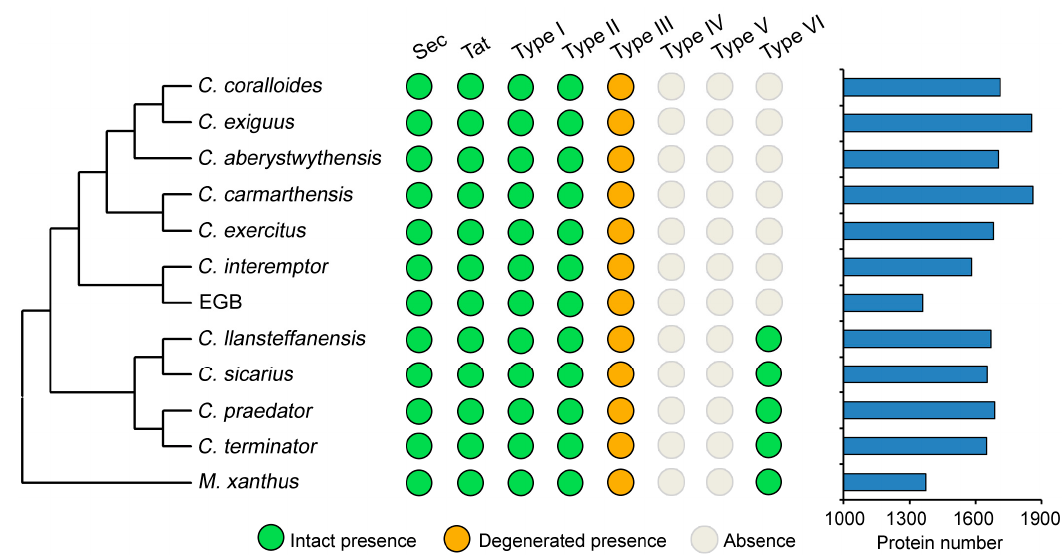
Figure 4. Distribution of secretion systems. The left part lists the relationship among species. The middle part shows presence or absence of each type of secretion system in each species. The right part represents the comparison of numbers of secreted proteins.